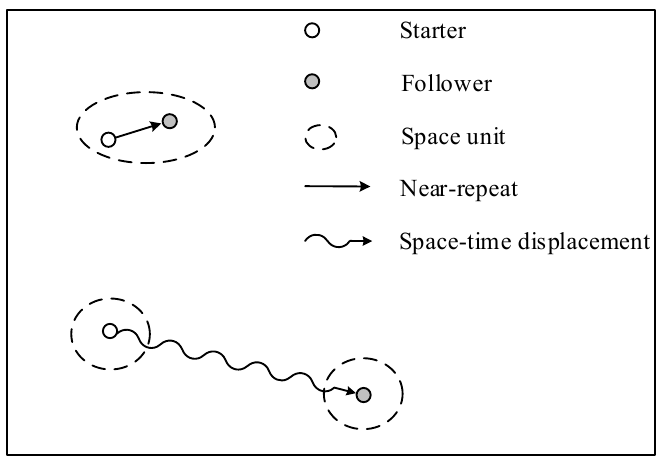
Figure 1. Near-repeat and space-time displacement.